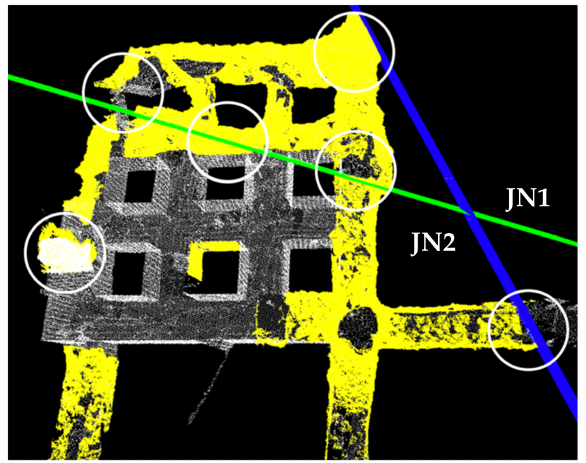
Figure 16. High-resolution cloud of points relating to underground infirmary rooms. The white circles indicate the position of the larger collapses. The green and blue planes indicate the position and orientation of two bands of weakness, parallel respectively to the families of discontinuities JN2 and JN1